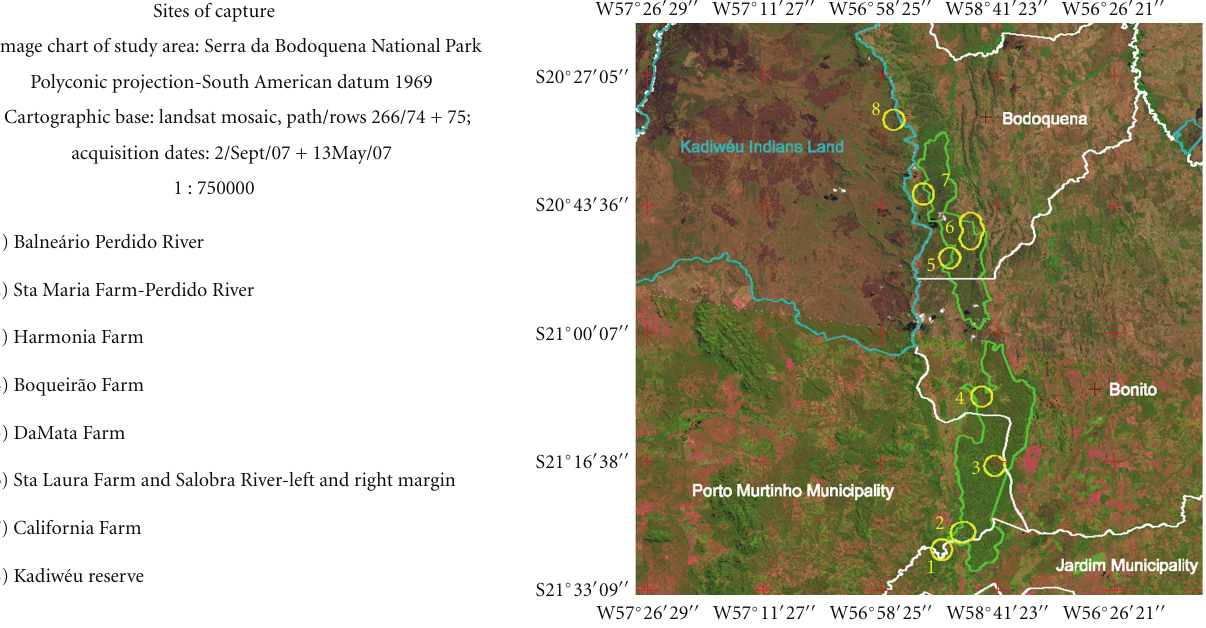
Figure 2: Landsat image indicating eight localities studied in Serra da Bodoquena National Park, Brazil. Obs: in Salobra river (site 6) three sampling points were performed (III, IV, and